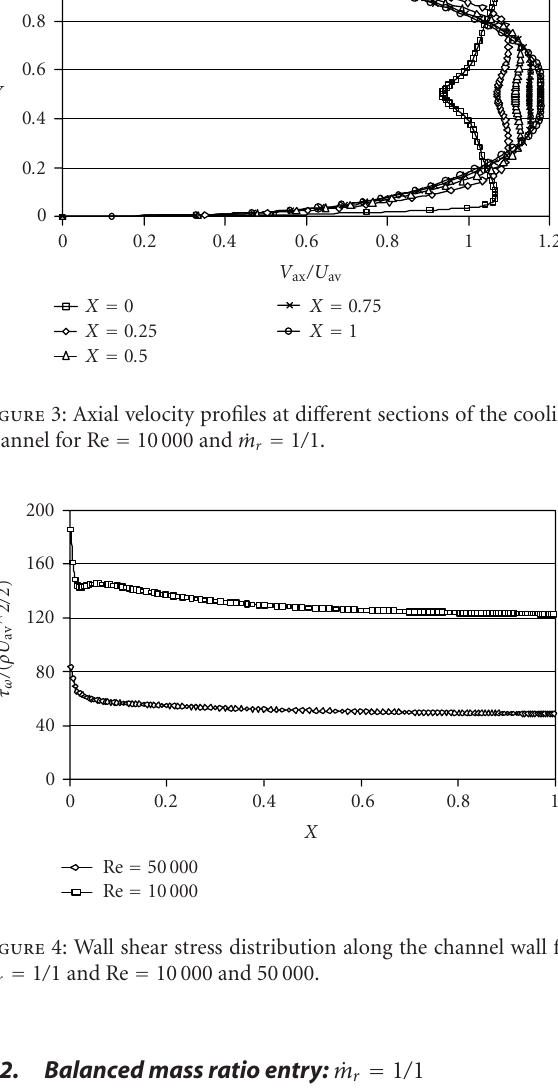
Table 1: Parametric case labels for di ff erent Reynolds numbers and mass flow rate ratios.